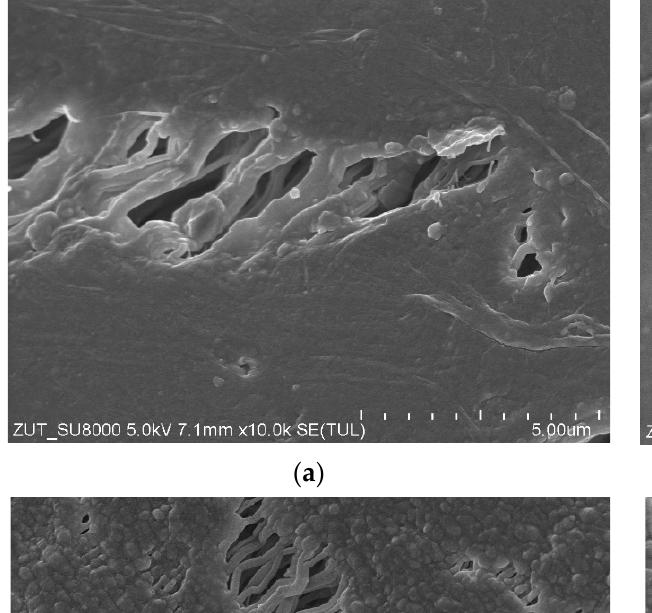
Figure 5. SEM images of the node–fibril structure for virgin and PTFE membrane used for the MD process (2000 h). External surface: ( a ) virgin; ( b ) after MD. Internal surface: ( c ) virgin; ( d ) after MD.